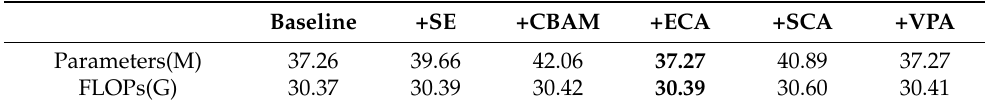
Table 2. The burden that different attention modules add to the Baseline. The bold indicates the best data.